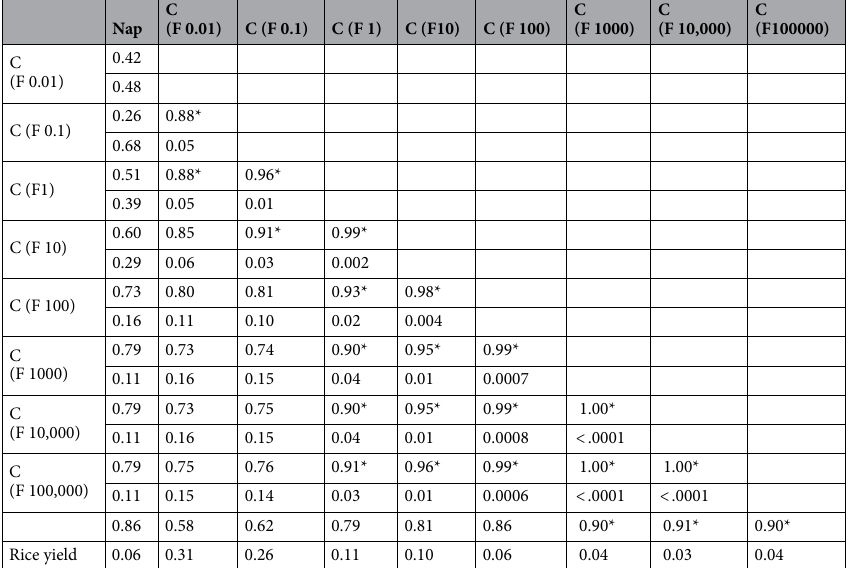
Table 6. Correlation among nitrogen fertilization, log real conductivity at different frequencies and grain yield. *Show correlation with yield at P ≤ 0.05. Where Nap = Urea applied during field study, C = Log conductivity, and F = Frequency at which soil samples were